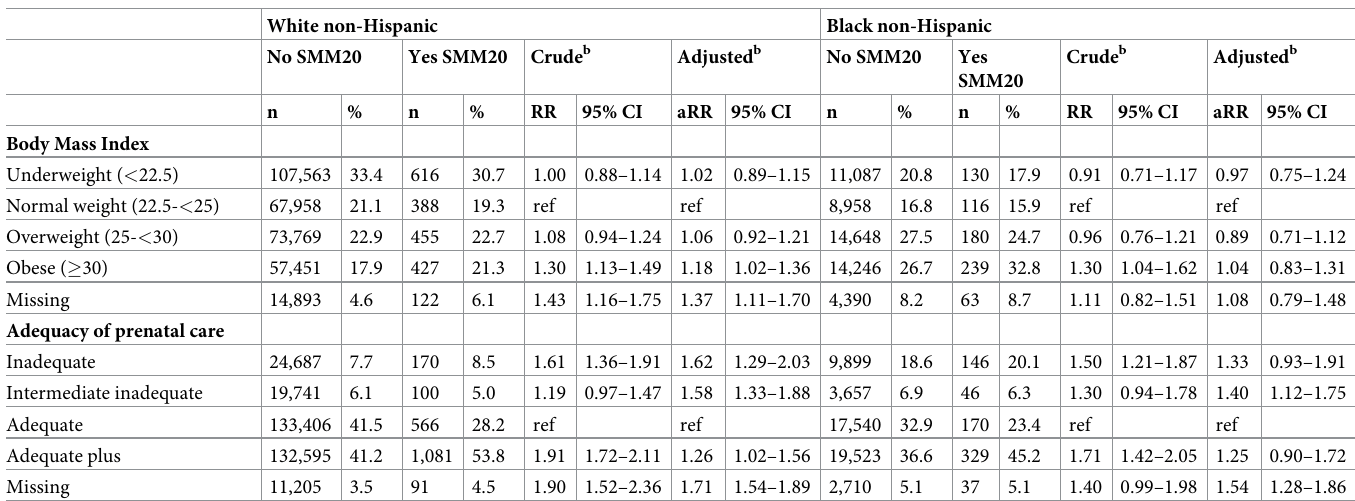
vigilant as vaccination, early identification and treatment of influenza is associated with improved outcomes among pregnant people [38]. Other studies of pregnant patients with influenza documented increased risk of SMM, increased incidence of hospitalization [39], ICU admission, pneumonia, ventilator support, and maternal or fetal death [40,41],